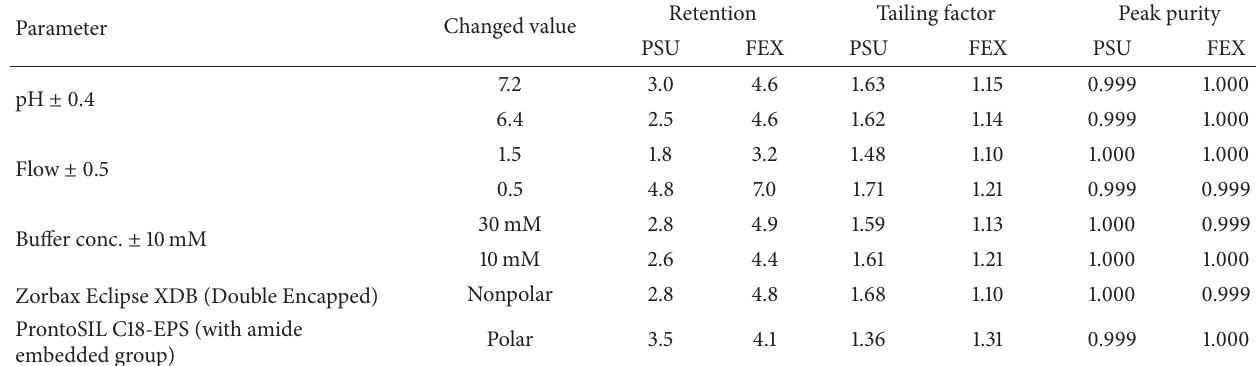
Table 9: Result of robustness